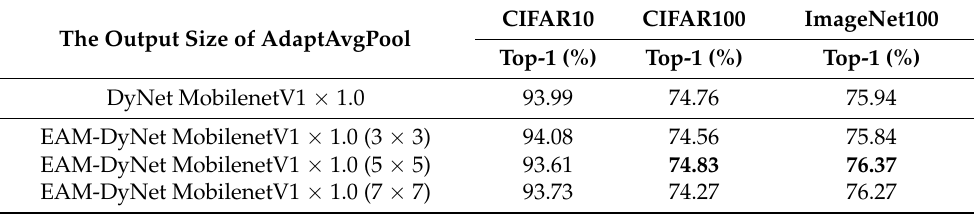
Table 7. The accuracy of adaptive pooling with different output sizes on EAM-DyNet MobilenetV1. The Output Size of